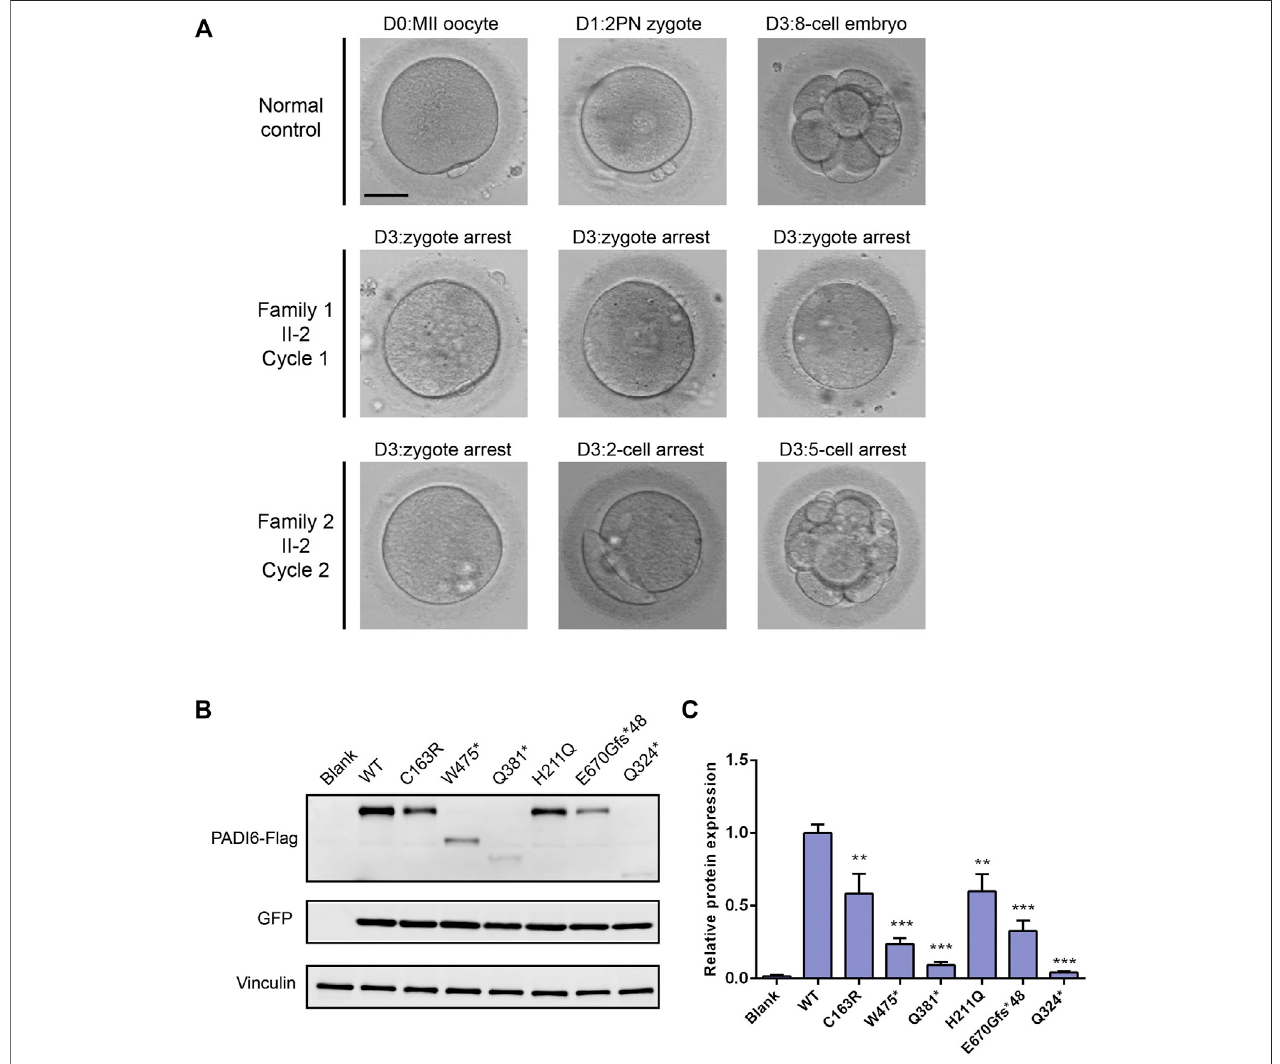
FIGURE3| Effectsofthevariantsonembryodevelopmentandproteinexpression. (A) Clinicalphenotypeofembryosfrompatientsandcontrol.Scalebar=40 µm. (B) Western blot analysis of PADI6 protein expression in HEK-293T cells transfected with wild-type and mutant plasmids. (C) Quantitative analysis of wild-type and mutant PADI6 protein level. N = 3 independent transfections. **, p < .01; ***, p < .001.